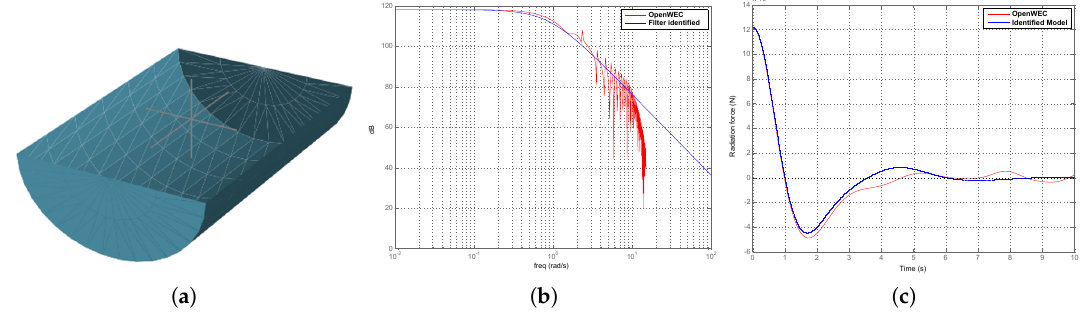
Figure 2. ( a ) Mesh defined by openWEC for a cylindrical buoy (11 m long and 7.5 m in diameter). Comparison of the identified transfer functions: ( b ) Bode diagram for excitation force F e ( s ) ; ( c ) impulse response for radiation force K r ( s )